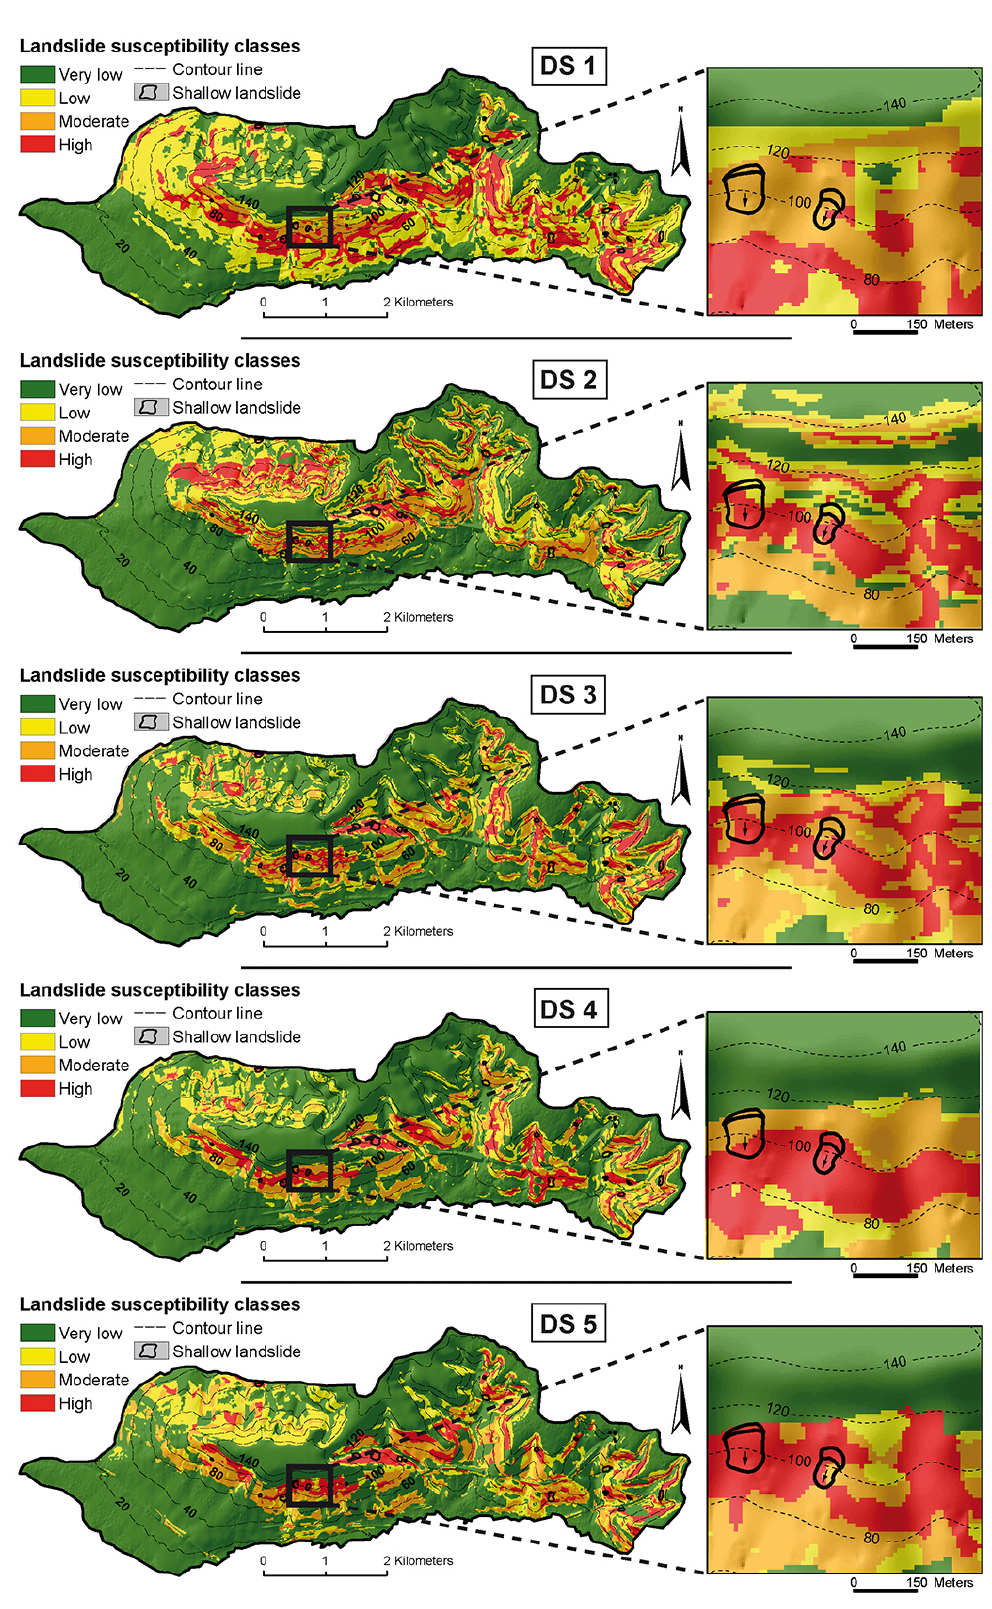
Fig. 11. Final classified modelled susceptibility maps for each model and illustrative zoom at the 1/10000 scale in a representative zone.